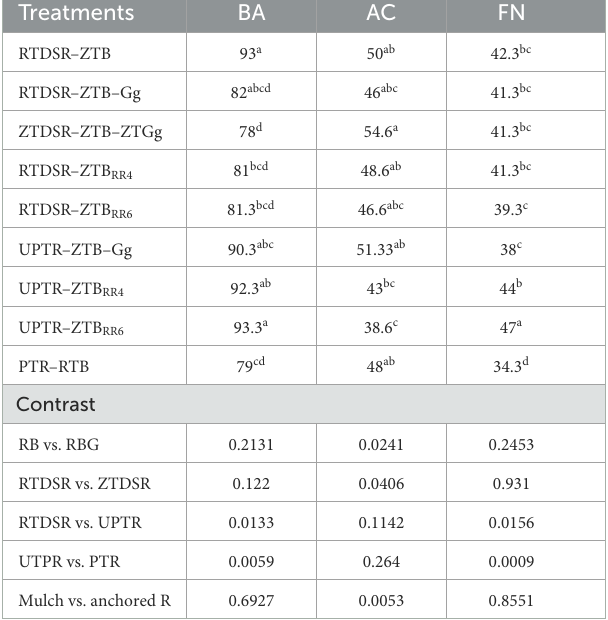
TABLE 4 Effect of tillage and residue management practices on soil microbial populations. Treatments